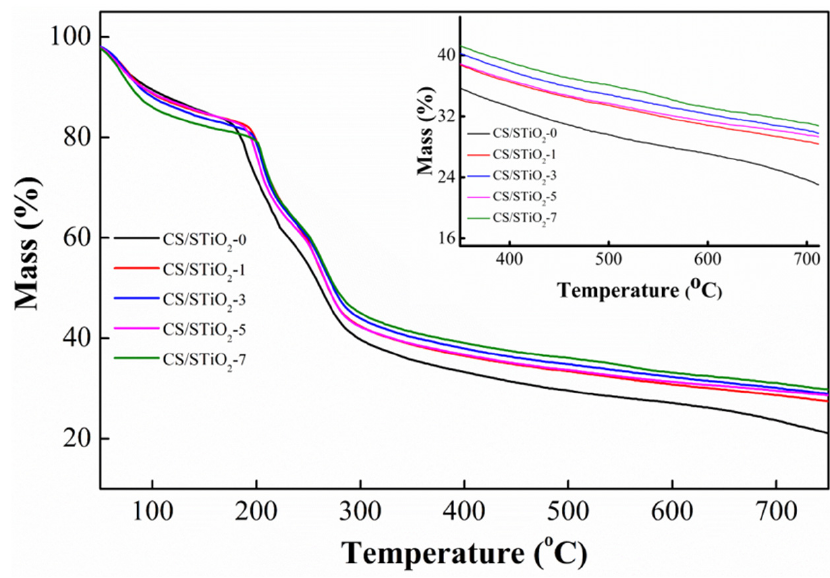
Figure 6. TGA curves of CS control and CS/STiO 2 nanocomposite membranes. Table 3. Mechanical properties of CS control and CS/STiO 2 nanocomposite membranes. Membranes Tensile Strength